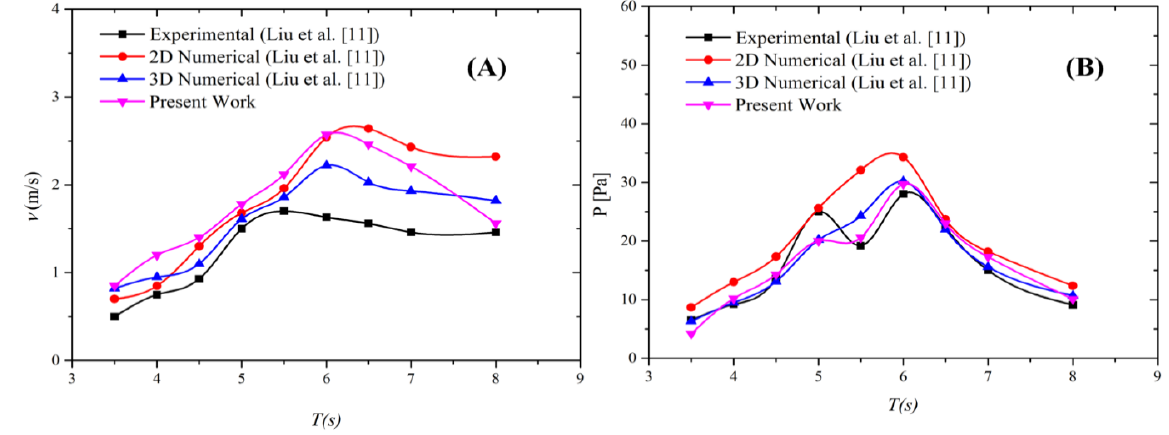
Figure 9. Comparison among the results obtained in the present study and those presented by Liu et al. [11] for different wave periods.